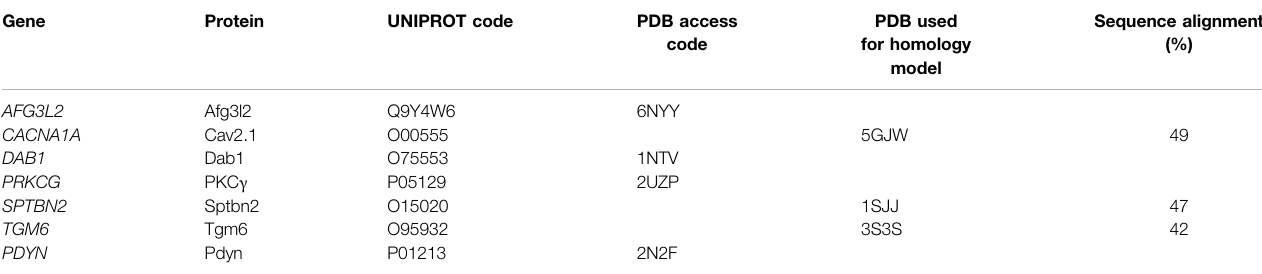
TABLE 1 | Proteins and the associated templates used for protein